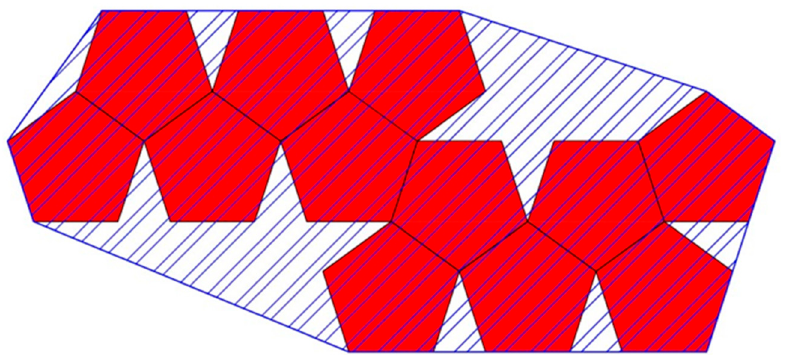
Figure 21. The convex hull (blue line) is defined by a convex polygon attaching all vertices on the exterior of a Dürer net configuration (red polygons) excluding any edges on the periphery that do not contribute to its convexity. The perimeter of the convex hull is the length of the blue line. The area of the convex hull is the area in the interior defined by the blue diagonal lines.